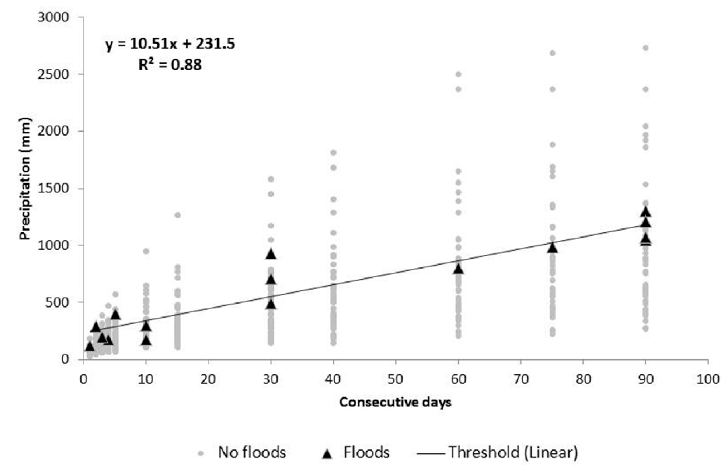
Figure 4. Precipitation quantity–duration threshold in the Corgo basin, defined by linear regression of flood events (Meteorological station:Lamas do Olo; Period 1946–1998).